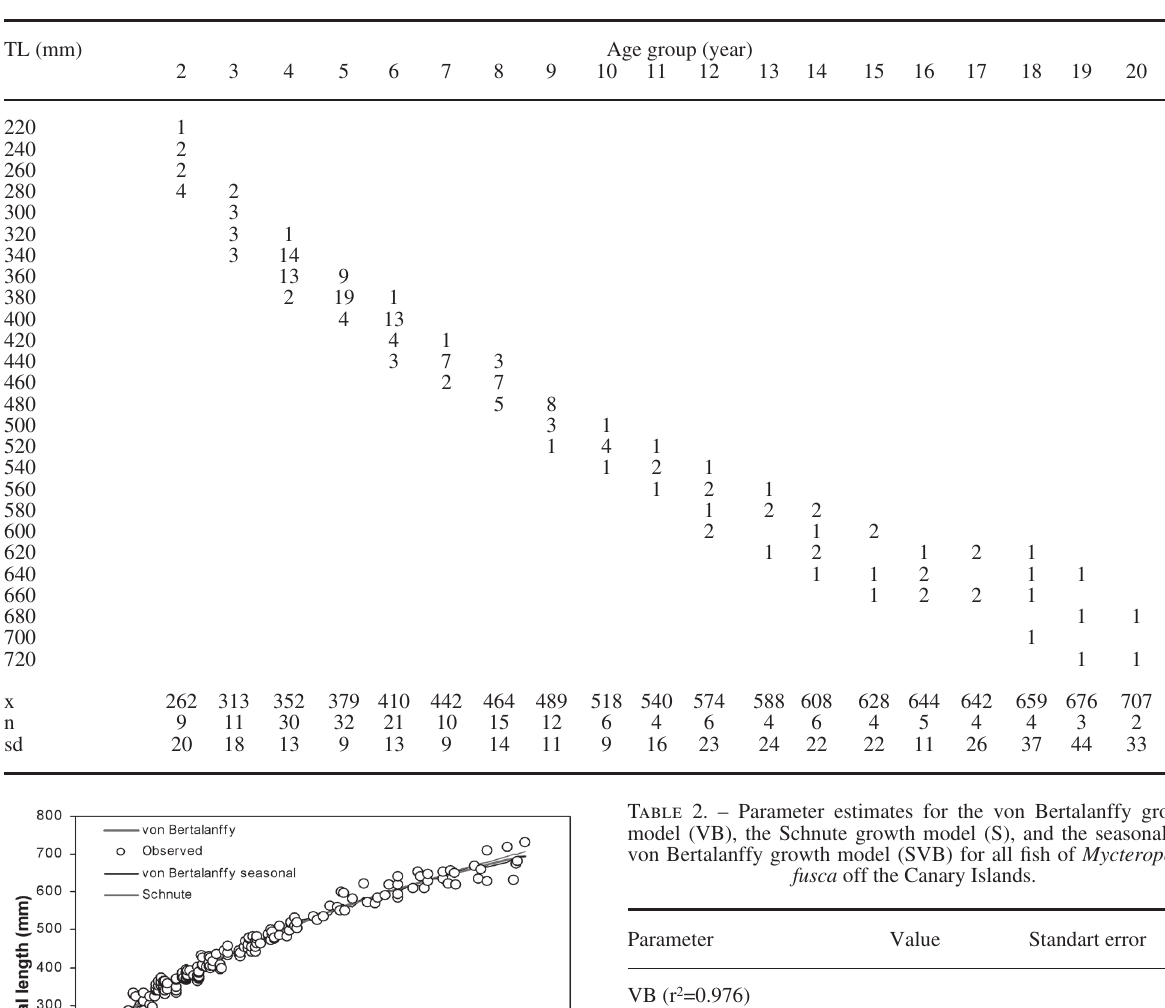
Table 1. – age-length key of Mycteroperca fusca off the canary Islands; x is the mean length; n, the number of fish by age class; and sd the standard deviation. total length classes are in 20 mm intervals.